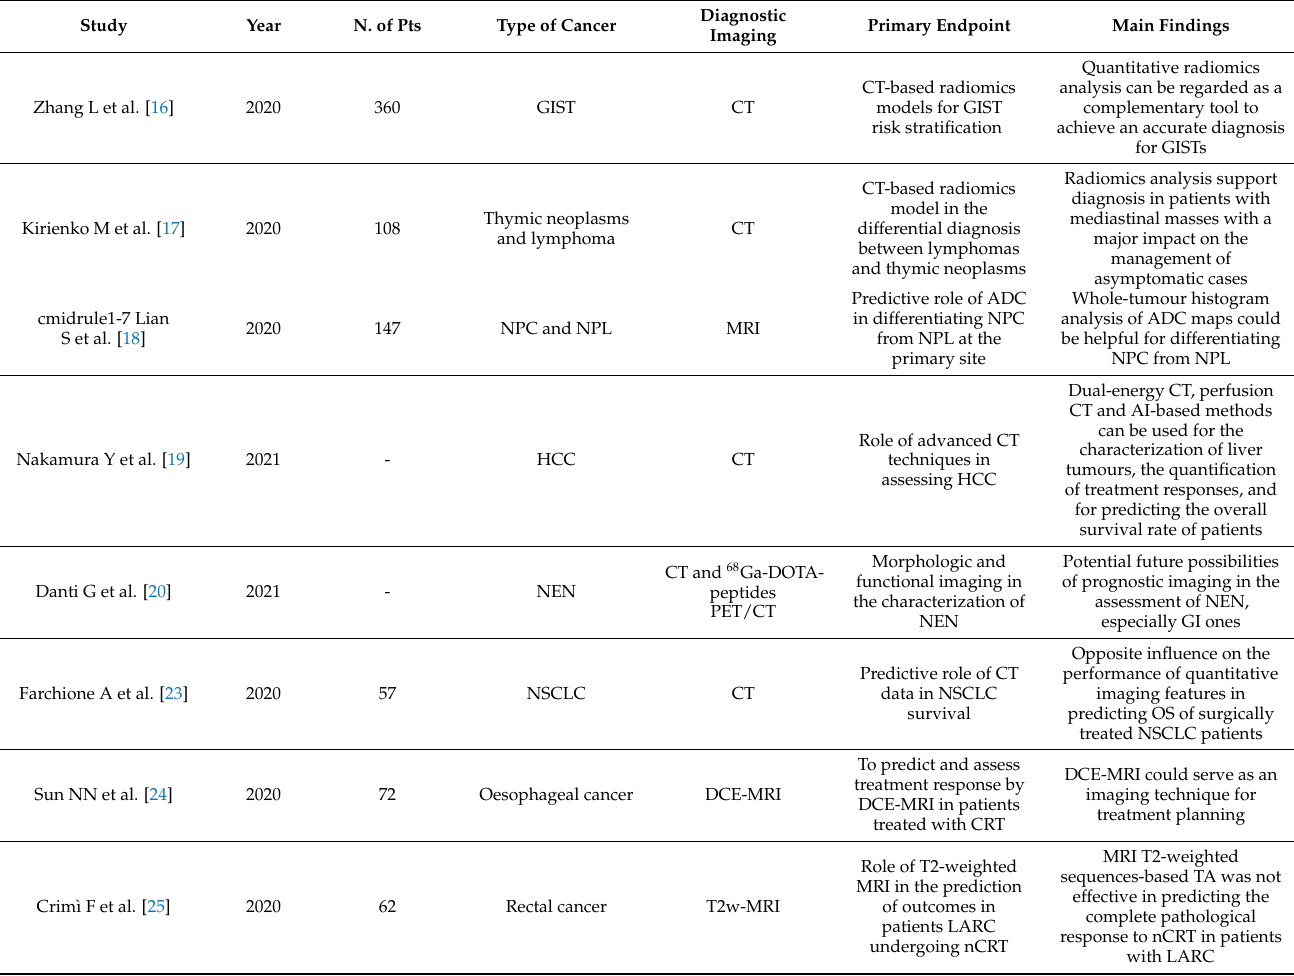
Table 3. Radiomics: role of imaging in predicting treatment outcomes in other